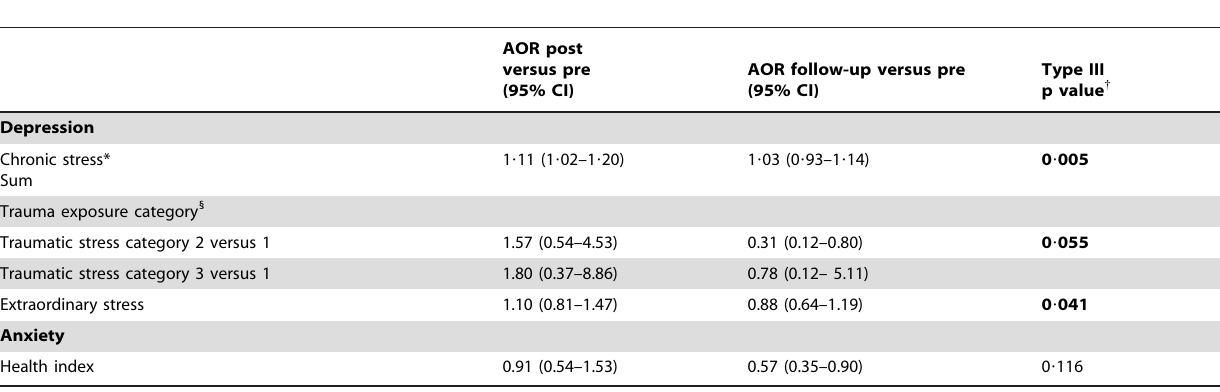
Table 2. Association between stressors and risk/mitigating factors and depression and anxiety, and how these changes across time, compared with pre-deployment as